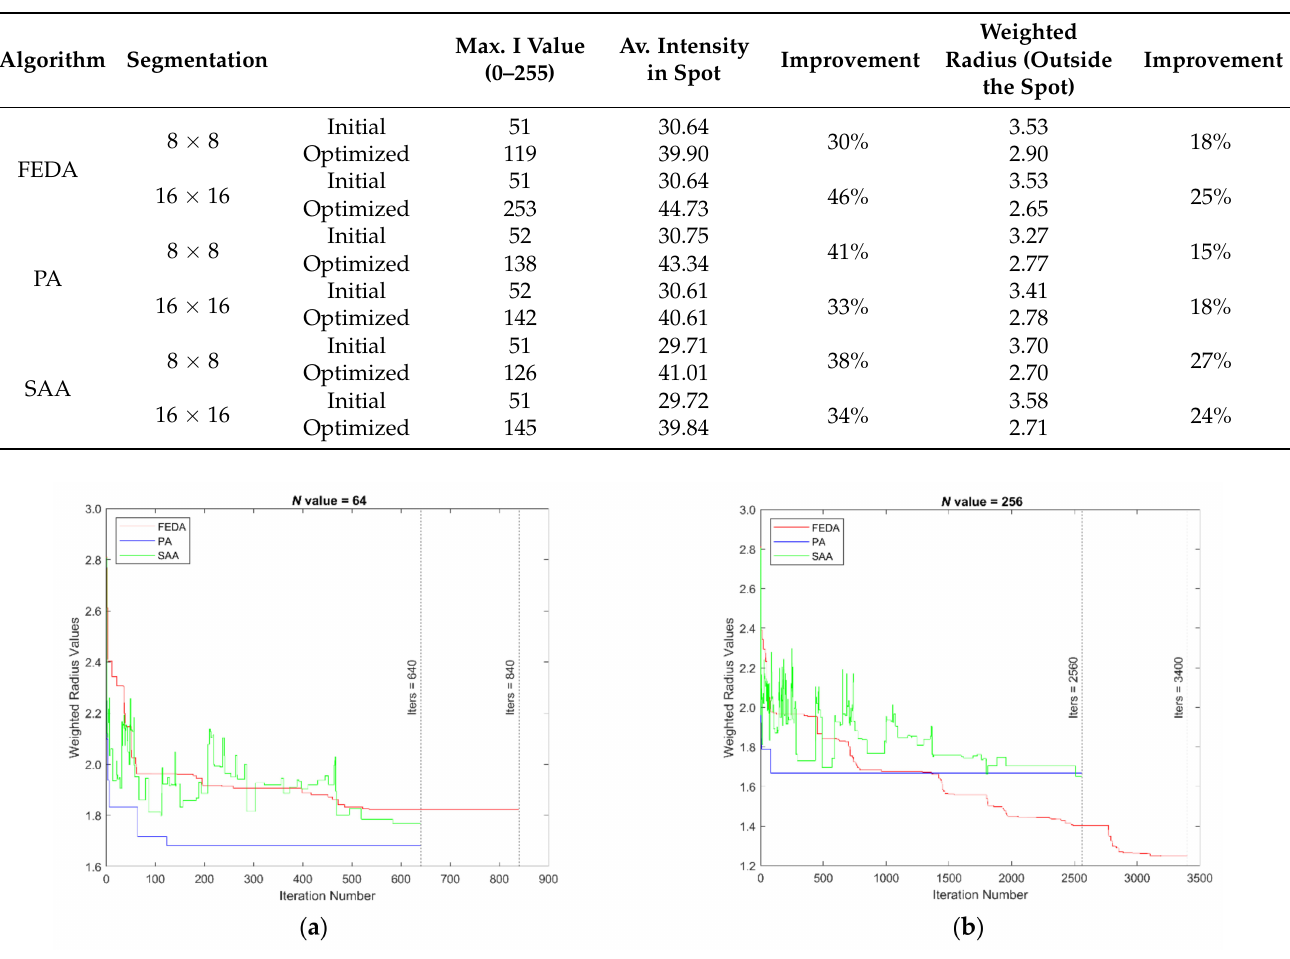
Figure 13. Convergence plots for the weighted radius: ( a ) optimization with 8 × 8 segmentation; ( b ) optimization with 16 × 16 segmentation. Table 3. Pluses and minuses of using each optimization